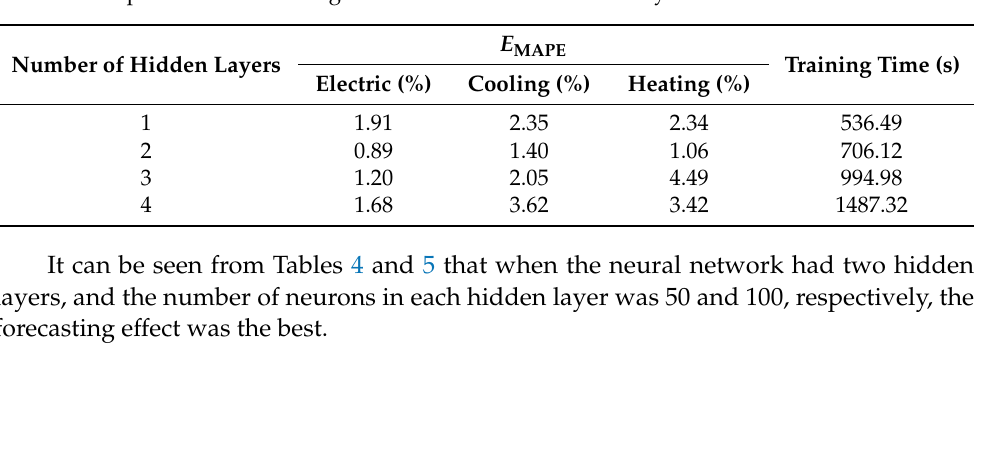
Table 4. Comparison of forecasting results with different hidden